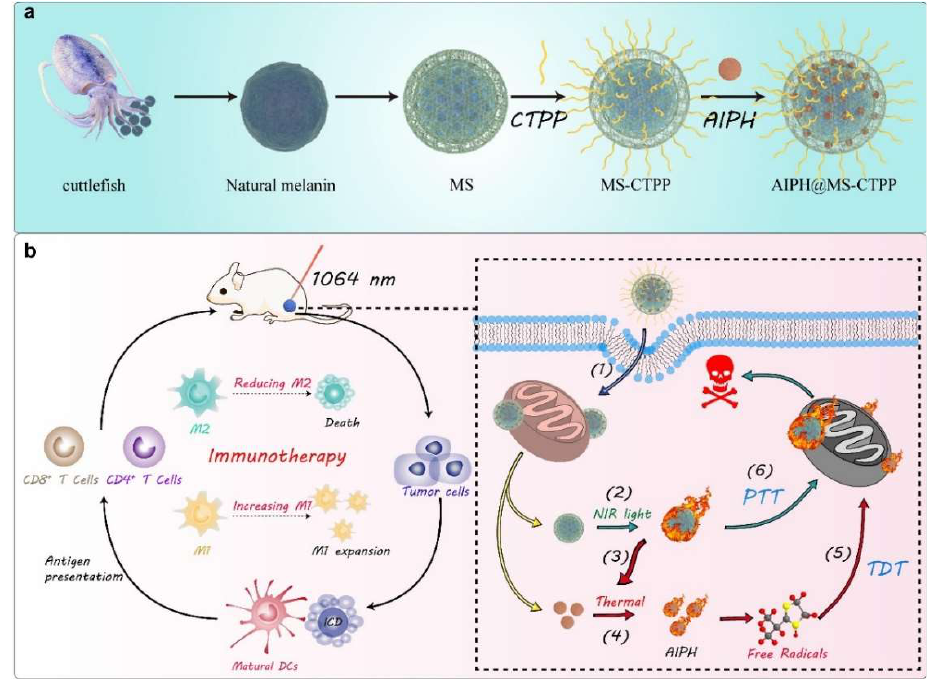
Figure 3. ( a ) Schematic illustrations of the construction of the AIPH@MS-CTPP nanostructures. ( b ) Schematic illustrations of the inhibition of tumor growth by AIPH@MS-CTPP-mediated synergizing NIR-II PTT, thermodynamic therapy, and immunotherapy. Reproduced with permission from [65]. Copyright 2022,